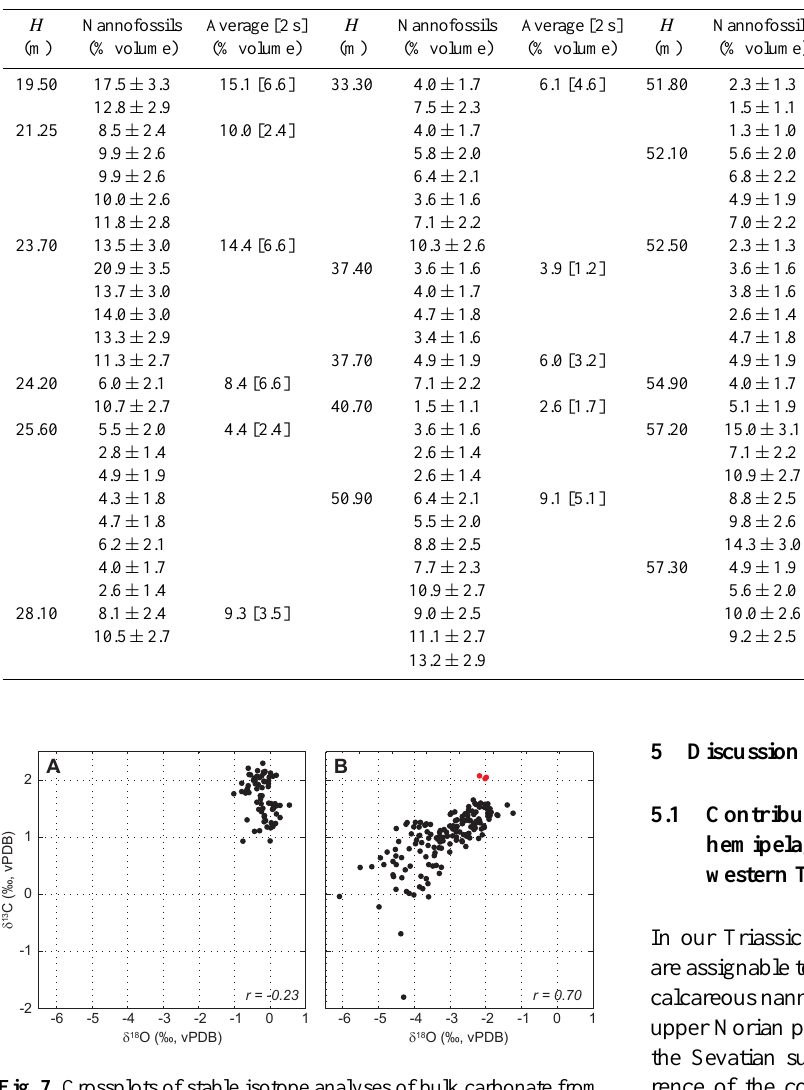
Fig. 7. Crossplots of stable isotope analyses of bulk carbonate from (A) Pizzo Mondello and (B) Pignola-Abriola. The samples marked in red are from a thick calciturbidite in the uppermost Norian por- tion of the Pignola-Abriola section. Correlation coefficients ( r ) are both significantly different from zero at the 95%